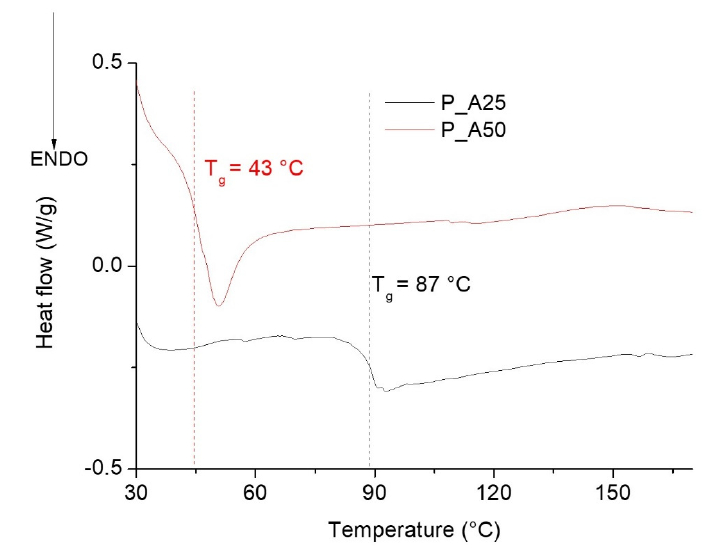
Figure 8. DSC analysis of postcured commercial epoxy at different amine contents.